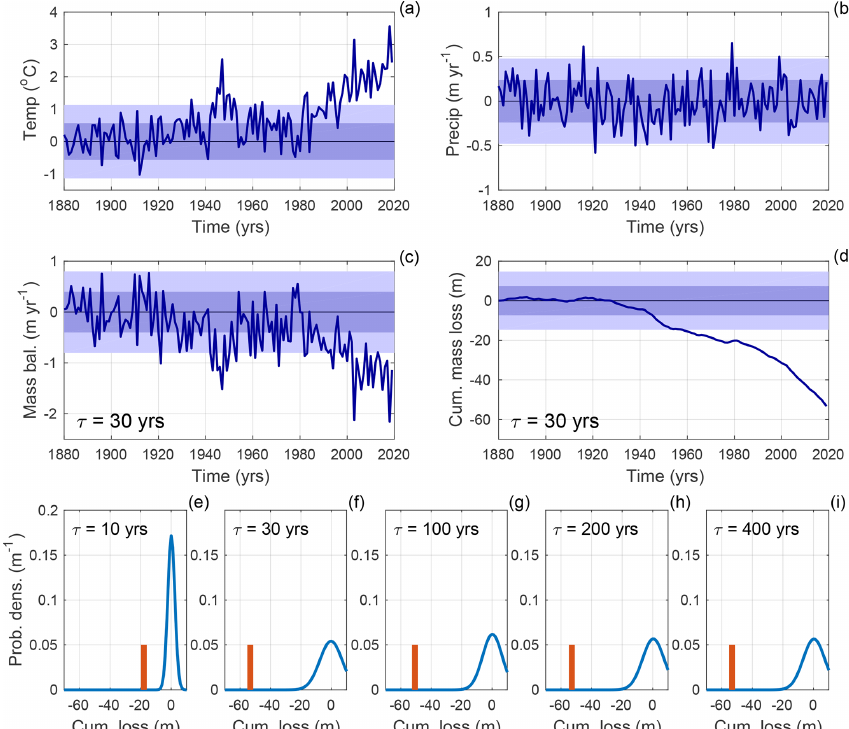
Figure 9. Signal-to-noise ratios of cumulative mass loss, estimated from observations in the Alps (47 ◦ N, 10 ◦ E). (a) Summer (April-to- September) temperature anomalies from the GISTEMP v4 dataset; (b) annual precipitation anomalies from the CRU TS4 dataset (values prior to 1900 were filled in with random values from the natural-variability statistics); (c) mass balance calculated using the three-stage model with τ = 30 years; (d) cumulative mass loss using three-stage model and τ = 30 years; (e) to (i) the PDF of cumulative mass loss expected in any 140-year period, based on estimated natural variability (blue line), compared to the cumulative mass loss calculated from the instrumental observations (orange bar). Each panel indicates the τ used in the three-stage model. The shading in panels (a) to (d) indicates the 1 and 2 σ bounds of the estimated natural variability, as described in the